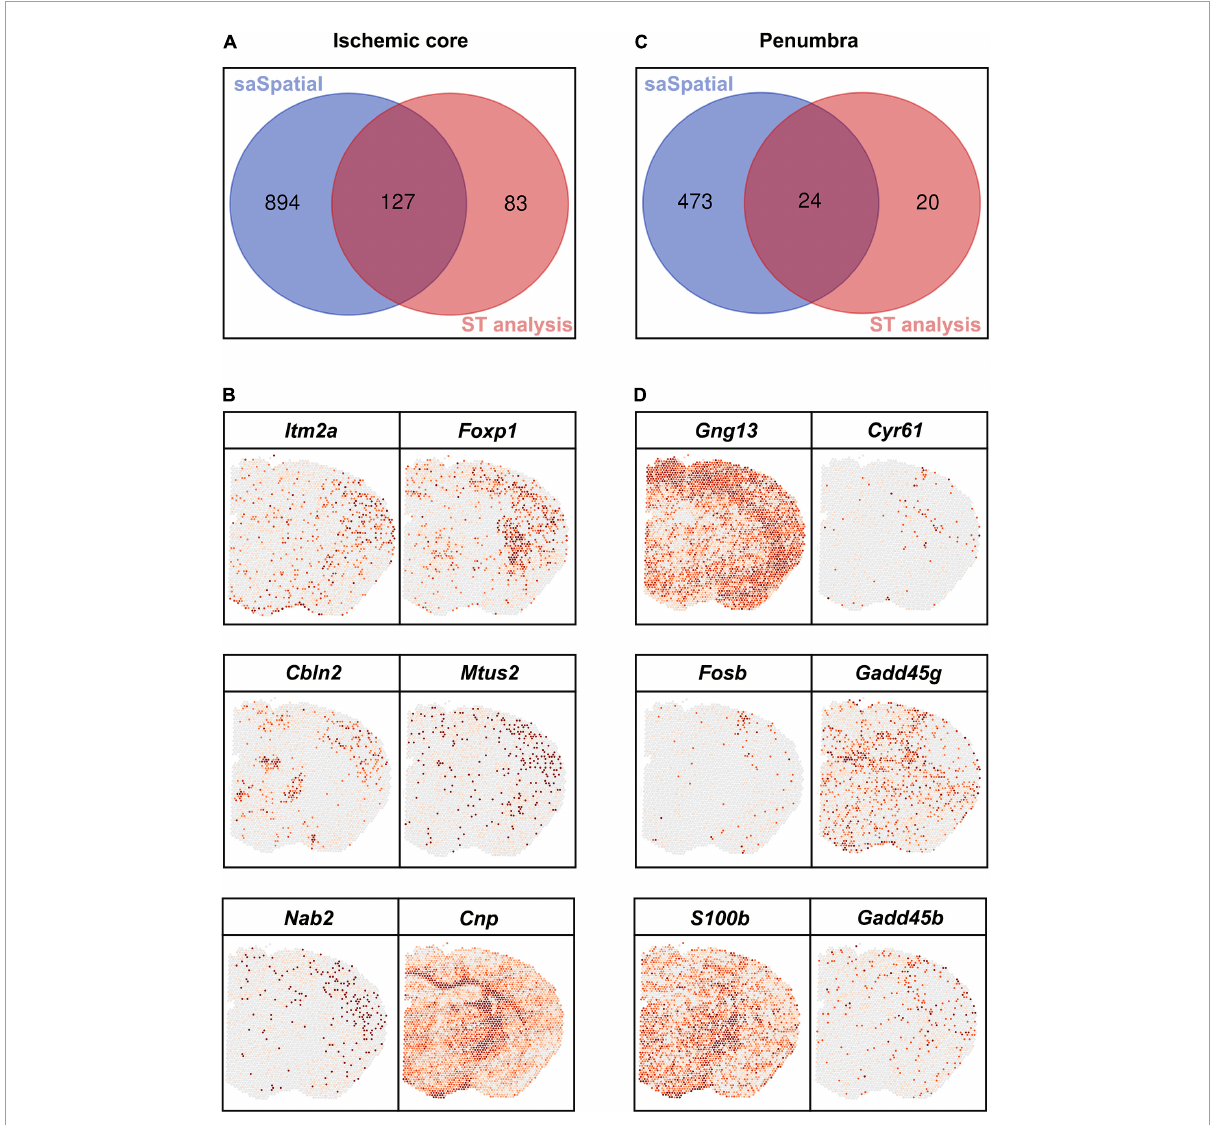
FIGURE6 Comparison between saSpatial and FindMarkers. (A) Venn map of ischemic core. (B) DEGs only found by saSpatial in the ischemic core. (C) Venn map of penumbra. (D) DEGs only found by saSpatial in the penumbra. N = 3. CI, confidence interval.